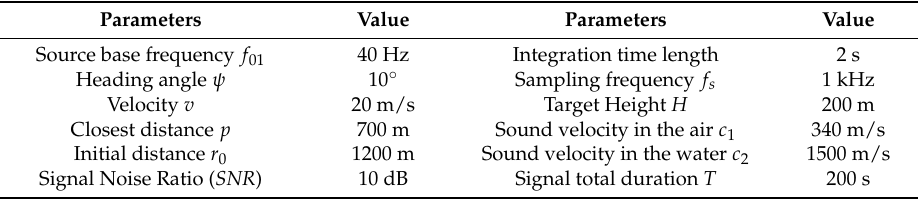
Table 1. The simulation parameters.